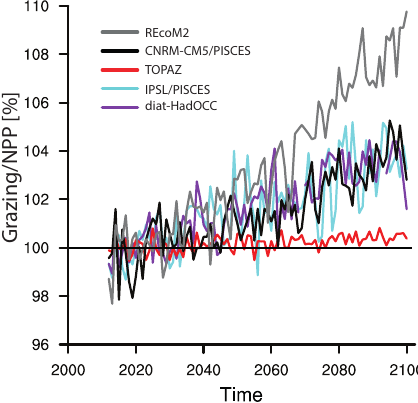
Figure 8. Fraction of NPP that is grazed (grazing/NPP) normalized to the 2012–2031 average at the surface of the low and high north- ern latitudes ( − 50 ◦ S–90 ◦ N). This plot shows data from all models where total grazing on phytoplankton is available in the